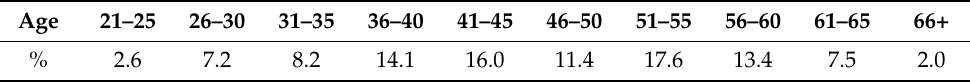
Table 1. Age of respondents (mean = 46.3. median = 46.5, s.d. = 11.0, n = 306).